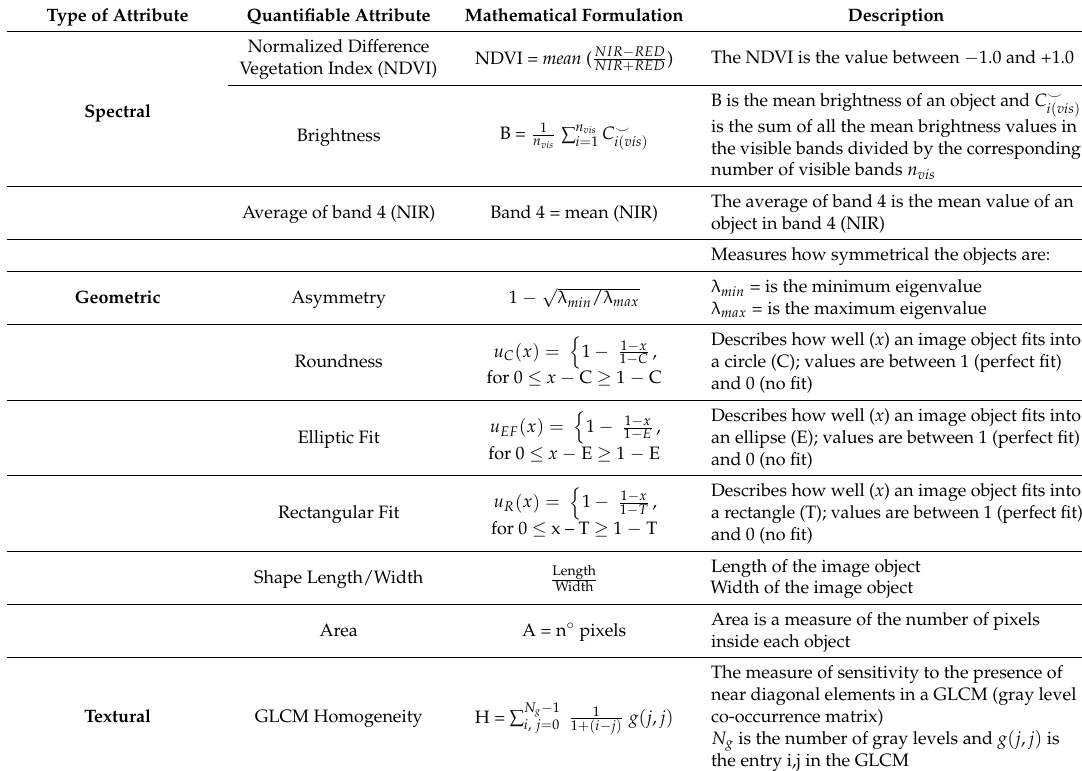
Table 1. Quantifiable attributes and inbuilt variables in